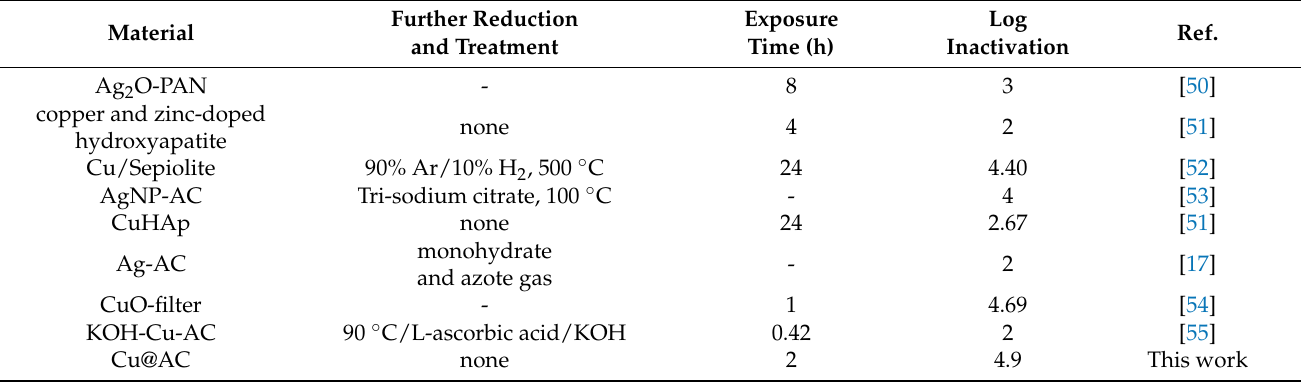
Table 1. Comparative table of E. coli inactivation using various metal nanoparticle-based